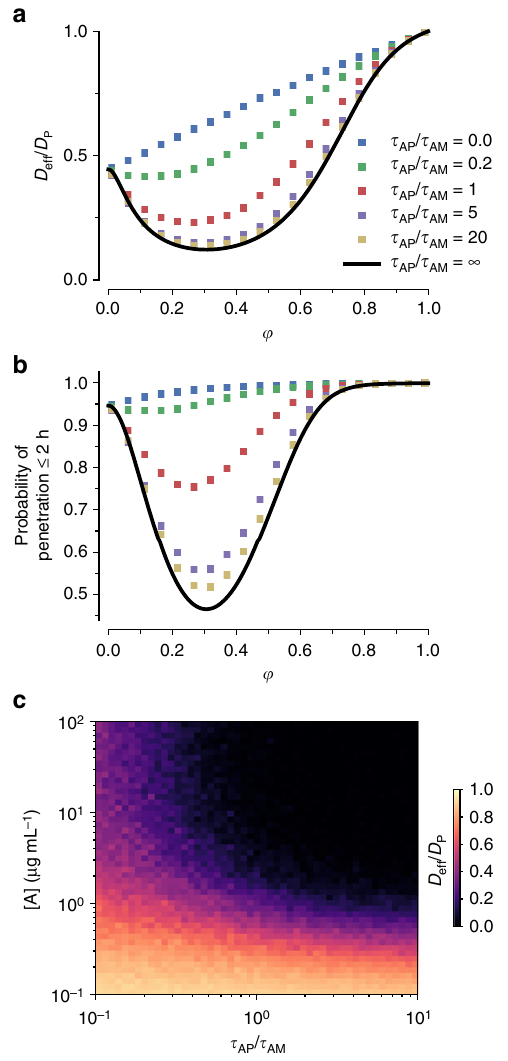
Fig. 2 Monte-Carlo simulations of the effect of timescale separation on trapping. Timescale separation is represented by τ AP = τ AM . a Reduction in effective diffusivity of nanoparticulates as a function of the free fraction of anchors, 0 < φ < 1, where 0 re fl ects anchors with permanent af fi nity and 1 re fl ects anchors with no af fi nity. b Probability of nanoparticulate penetrating across a layer of thickness L = 50 μ m within 2 h. Solid lines show the τ AP = τ AM ! 1 approximation. c Heat map of the effective diffusivity vs. the anchor concentration and timescale separation. Parameter values used: